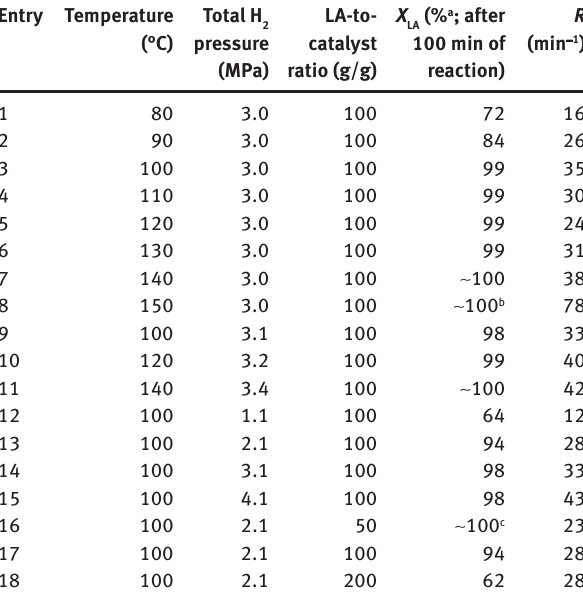
Table 1: Results of catalytic testing of 5%-Ru/C-H reaction conditions.